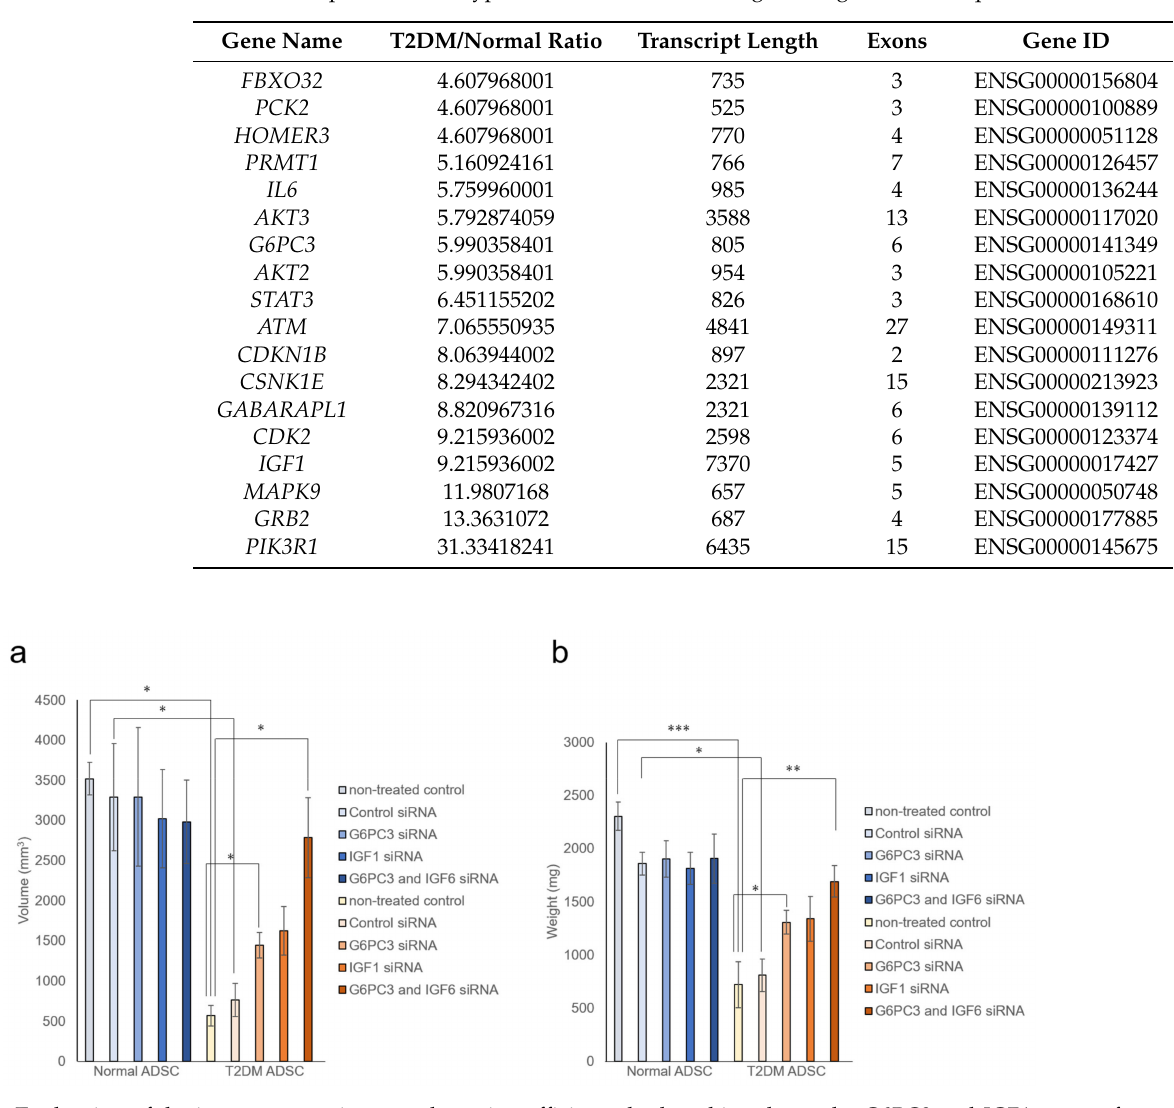
Figure 5. Evaluation of the improvement in transplantation efficiency by knocking down the G6PC3 and IGF1 genes